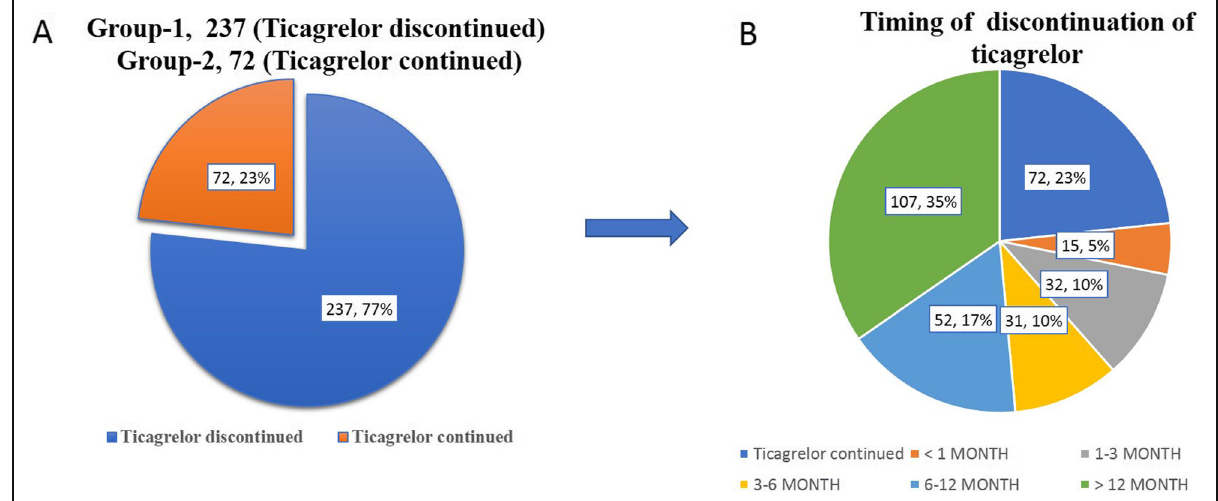
Fig. 1 a Percentage of patients who discontinued ticagrelor. b Timing of discontinuation of Ticagrelor.